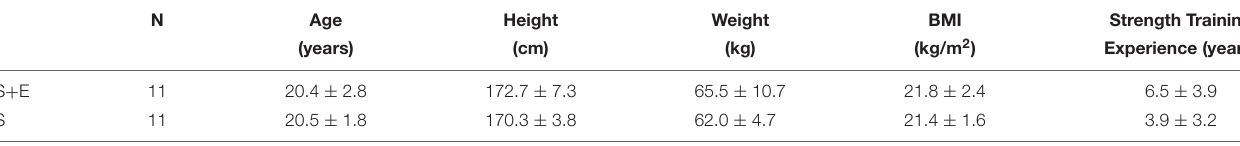
TABLE 1 | Anthropometric data (mean ± SD).